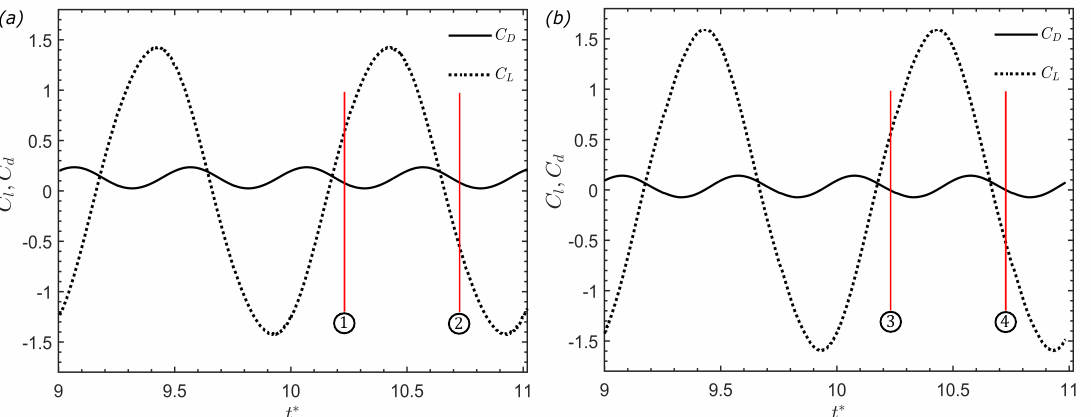
Figure 11. Variation of Coefficients of lift ( C l ) and drag ( C d ) with normalized time t ∗ , for ( a ) Case 6 and ( b ) Case 7, respectively.